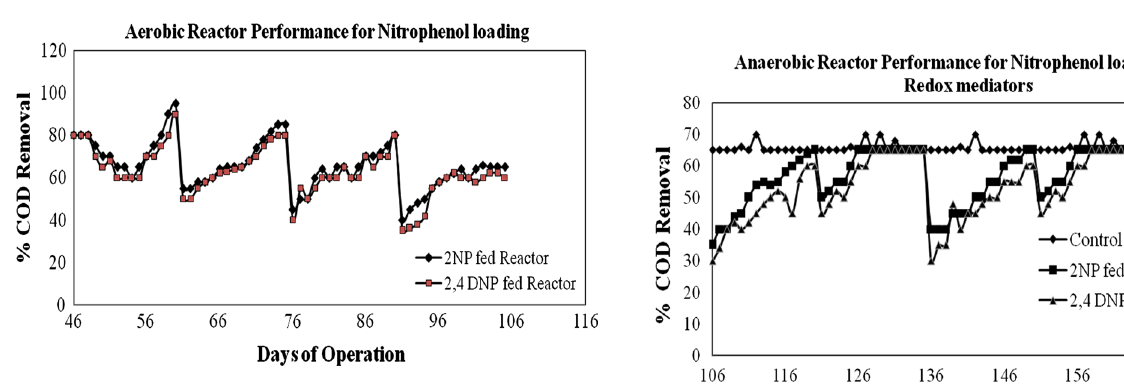
Fig. 6 Nitrophenol removal efficiency for aerobic reactors